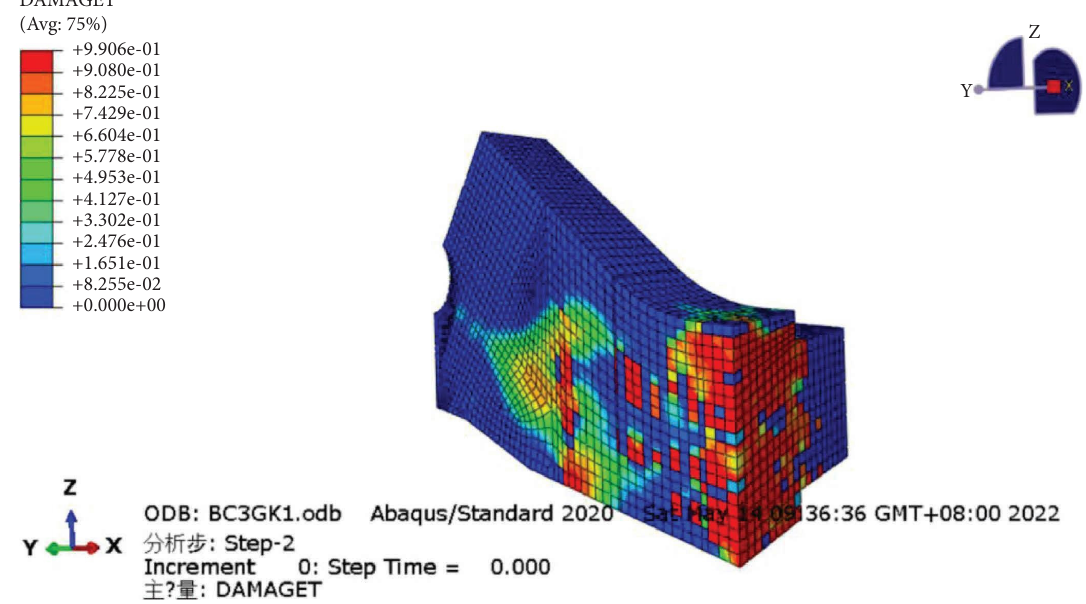
Figure 9: Cloud chart of tensile plastic damage of concrete of condition 10.